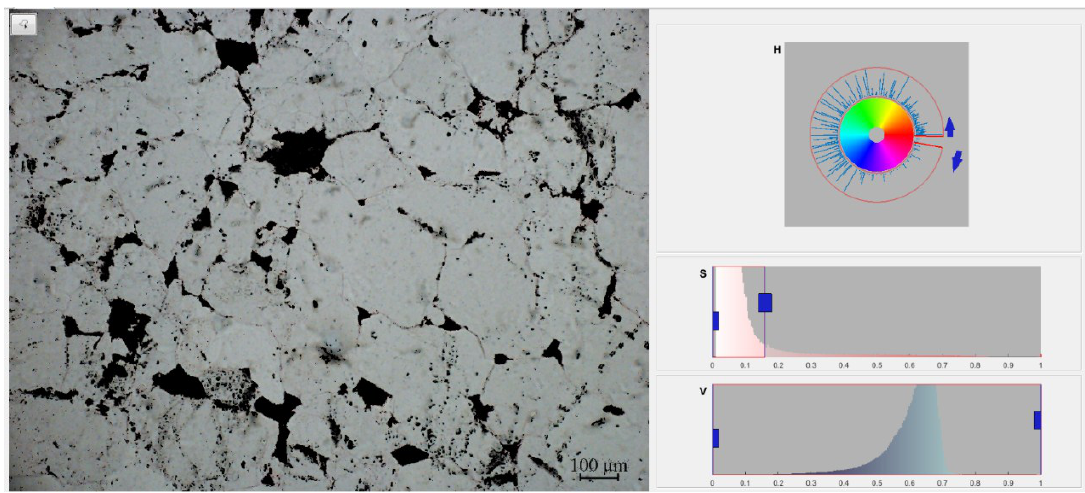
Figure 2. Binarization of casting thin section.